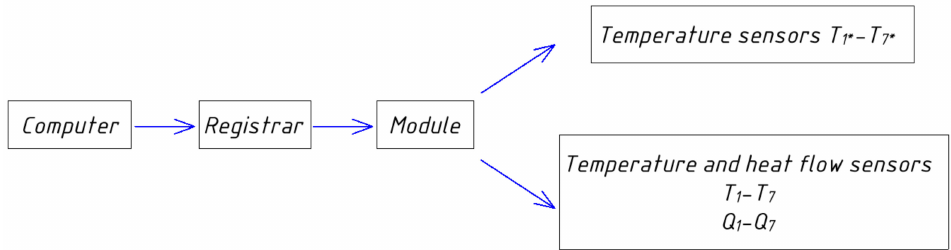
Figure 2. Schematic diagram of the device operation (T 1 -T 7 are temperature measurement sensors, Q1-Q7 are flow measurement sensors, T 1* -T 7* are additional sensors for temperature measurement). The wall panel size made by the additive method was 390 mm × 680 mm × 310 mm. The wall thickness of the structure was 35